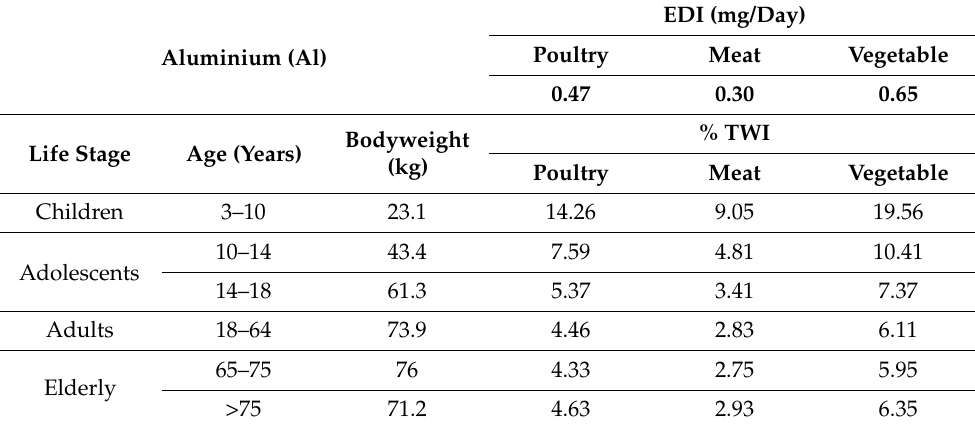
Table 6. Estimated daily intake and contribution percentage to the tolerable weekly Al